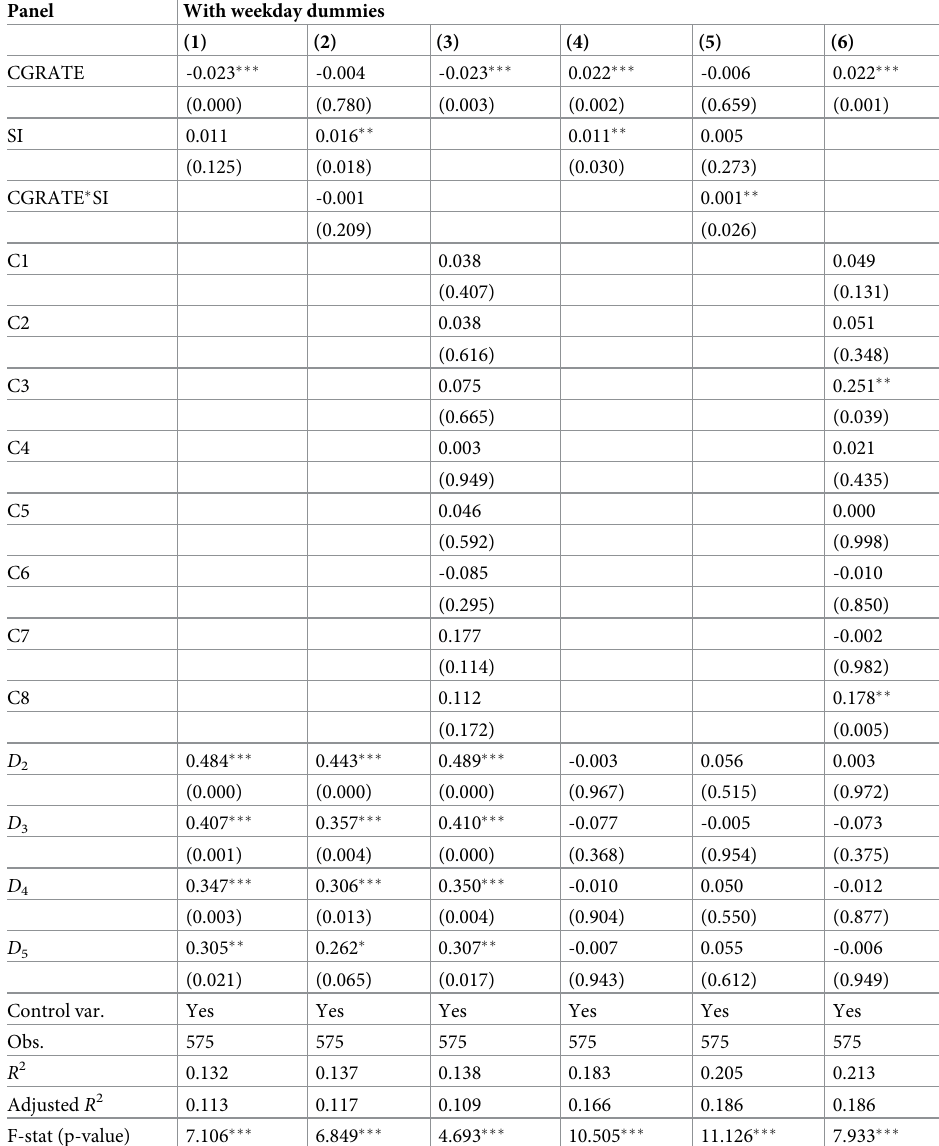
Table 11. Robustne ss tests: Additional control variables. Panel